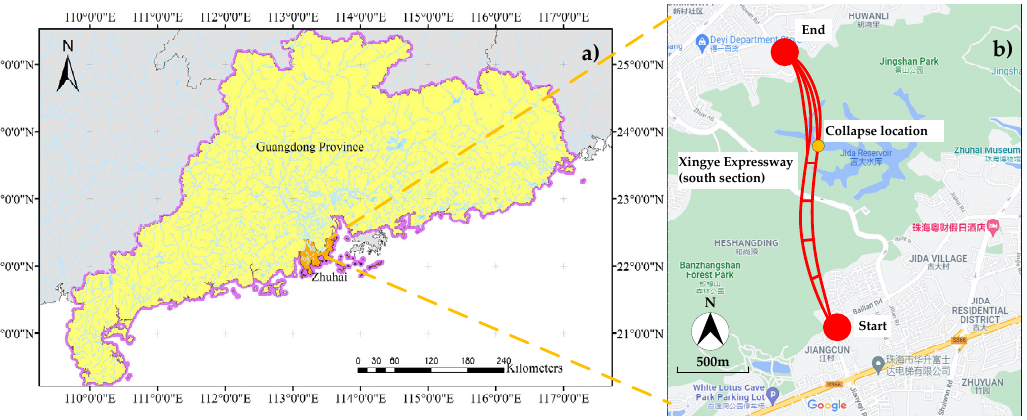
Figure 1. Location map of the collapsed tunnel: ( a ) map of water system, Guangdong Province; ( b ) accident tunnel due to inrushing in Zhuhai, Guangdong Province, on 15 July (map Google map).